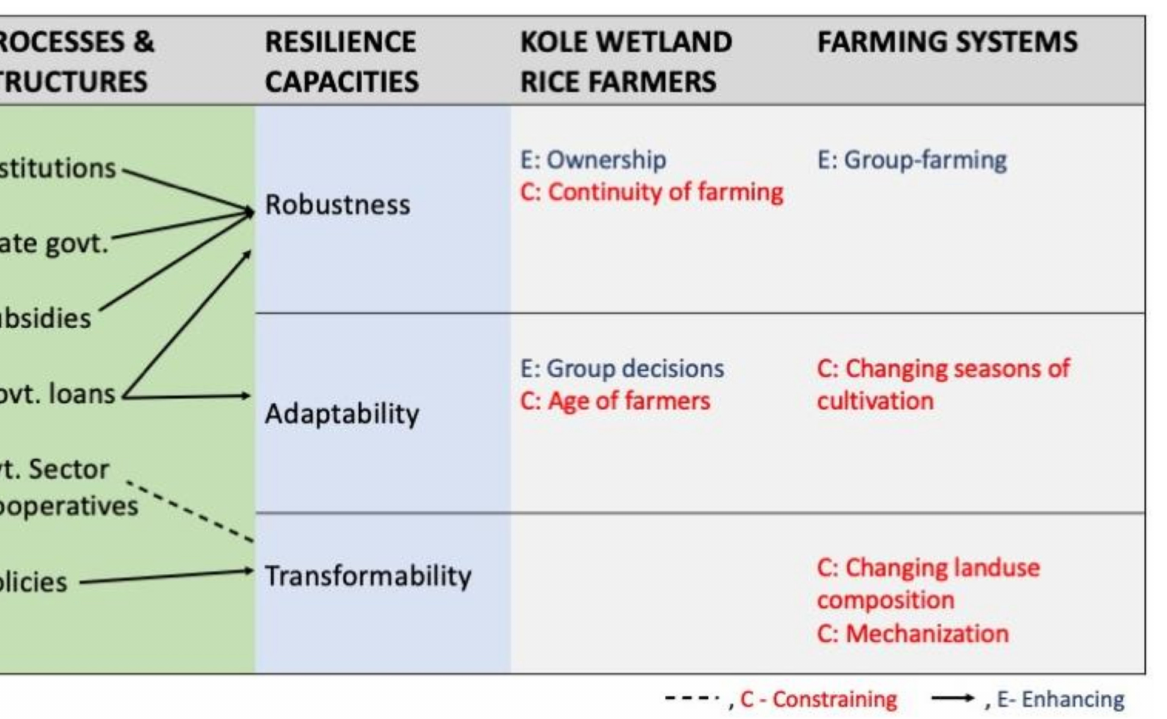
Figure 4. Resilience capacities, processes, and structures of Kole wetland rice